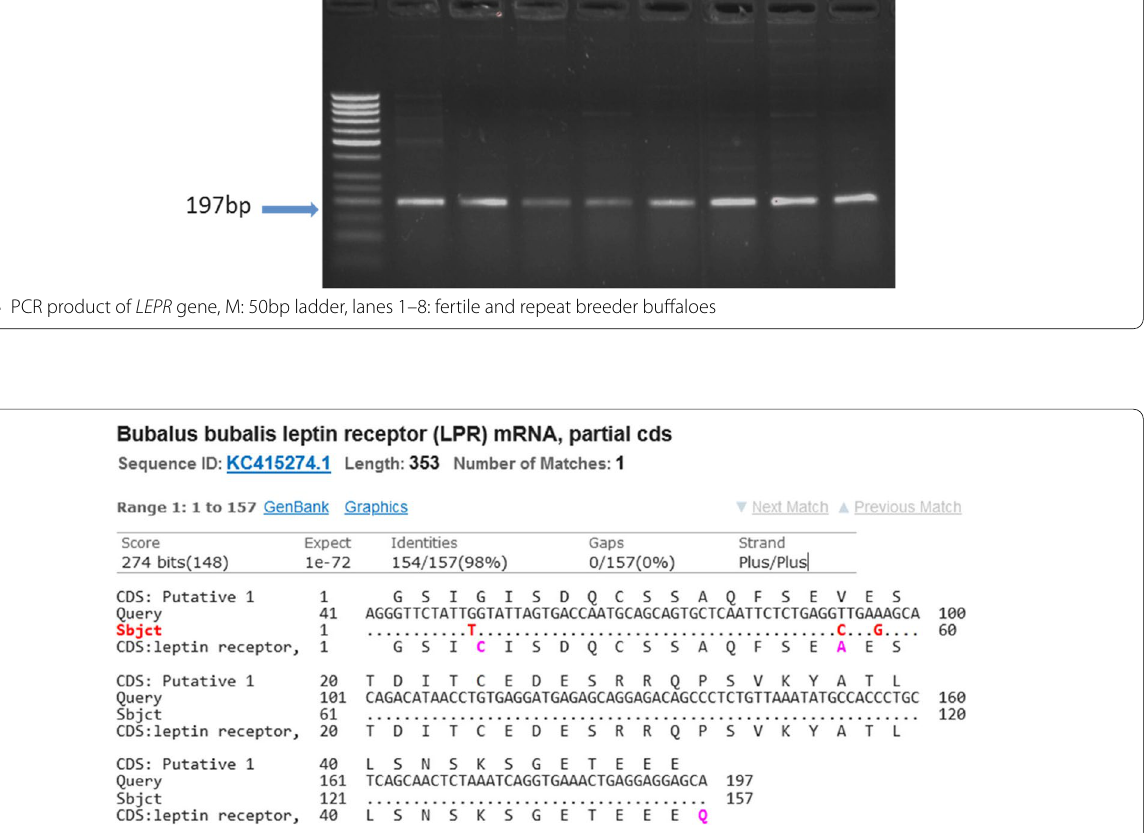
Fig. 5 The detected G52T, T92C and A96G SNPs in the amplified LEPR sequence and its homologues Bubalus bubalis sequence in the GenBank